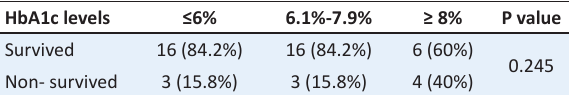
Table 3. Comparison of survival rates of groups based on HbA1c values using chi-square test HbA1c levels